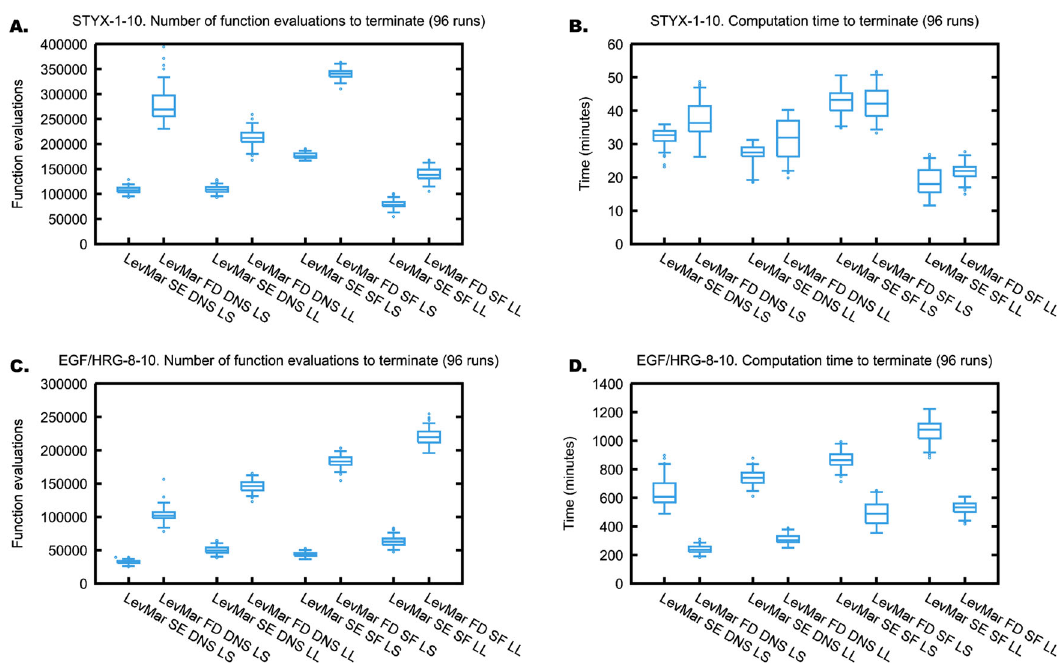
Fig. 3 Convergence speed of LevMar SE and LevMar FD. Boxplots ( n = 96) as in Fig. 1. a Required number of function evaluations to terminate and b computation time to terminate for the STYX-1-10 problem. c Required number of function evaluations to terminate and d computation time to terminate for the EGF/HRG-8-10 problem. DNS normalisation of the simulations, LL log-likelihood, LS least squares, SF scaling